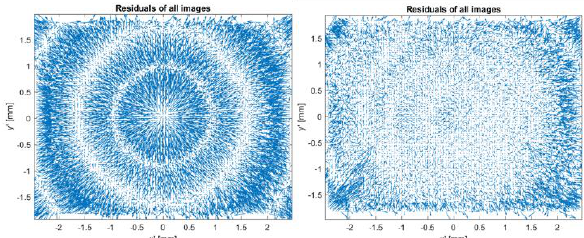
Figure 16. Residual components plotted against image coordinate components for iPhoneX B